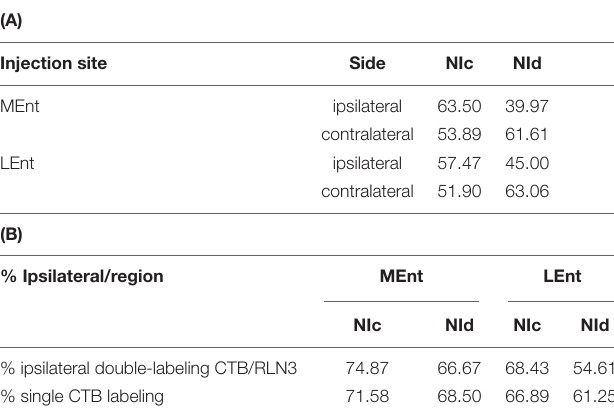
TABLE 2 | Percentage of retrogradely CTB labeled neurons after injections in the MEnt ( n = 4) or LEnt ( n = 4) that were also positive for RLN3 in each division of the NI. (B) Percentage of ipsilateral labeling (from total labeling) in double CTB-RLN3 or single CTB labeled material after tracer injection in the MEnt ( n = 4) or LEnt ( n =